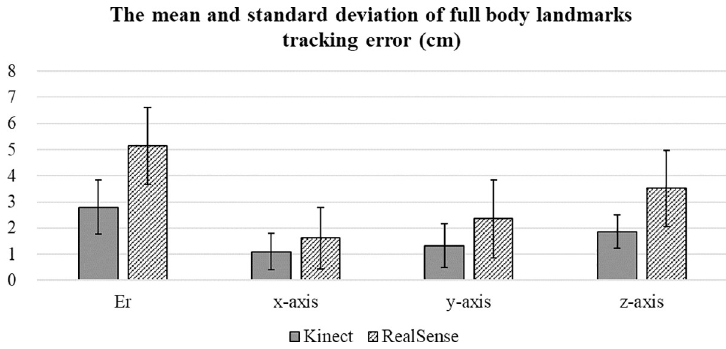
Fig 7. The average error value of the Kinect system and RealSense system in 3-D space.